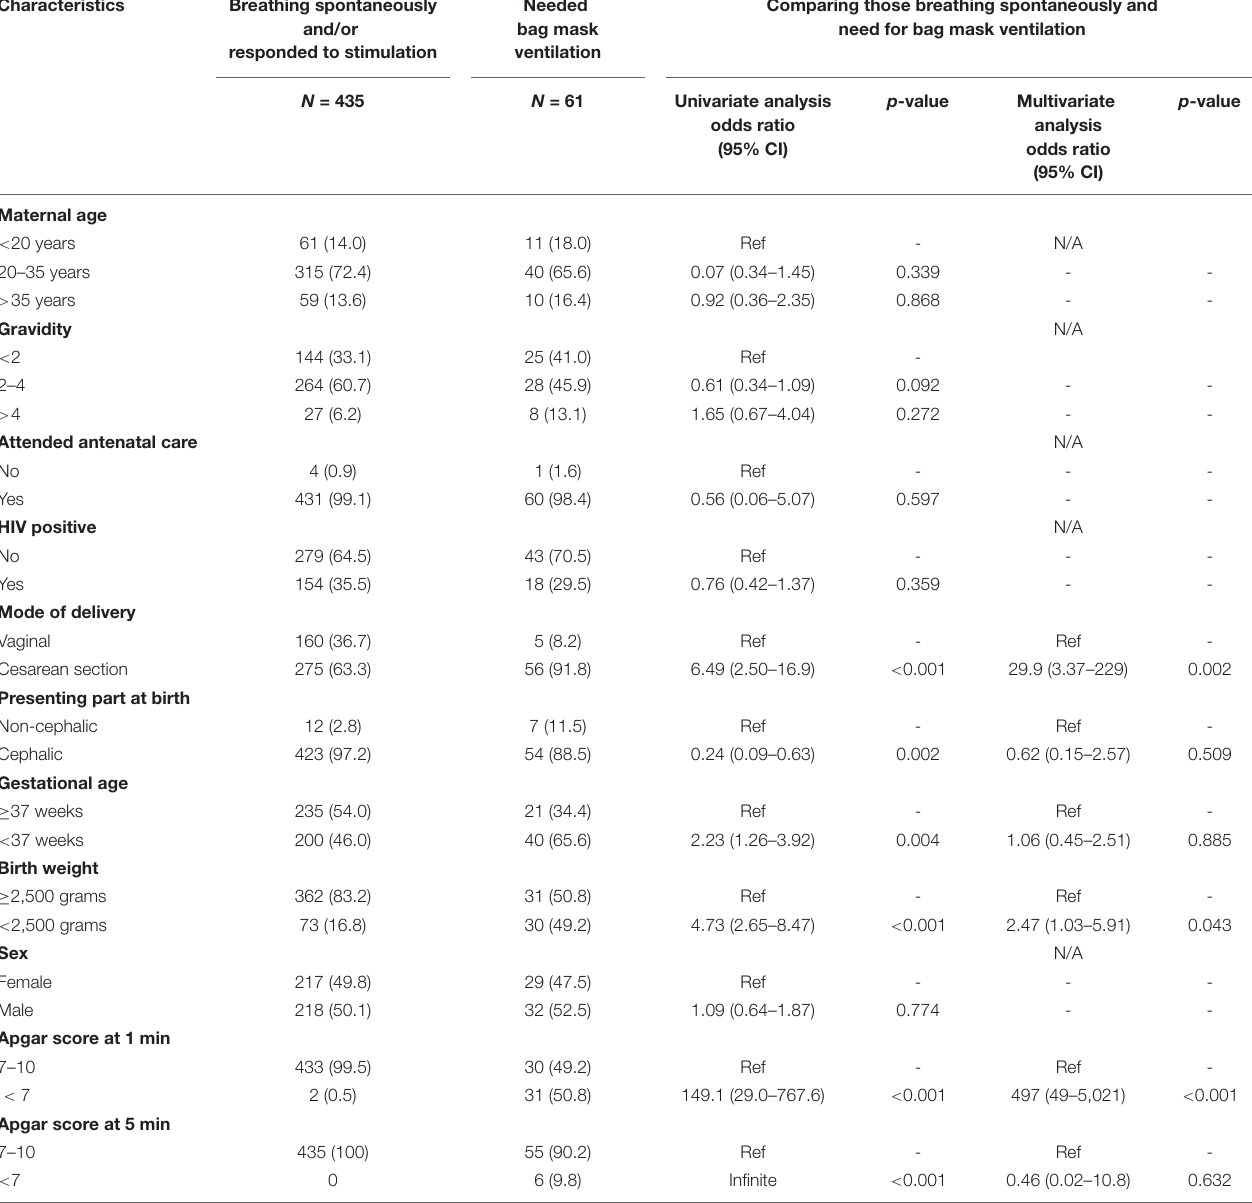
TABLE 3 | Comparing neonates requiring bag mask ventilation and those who did